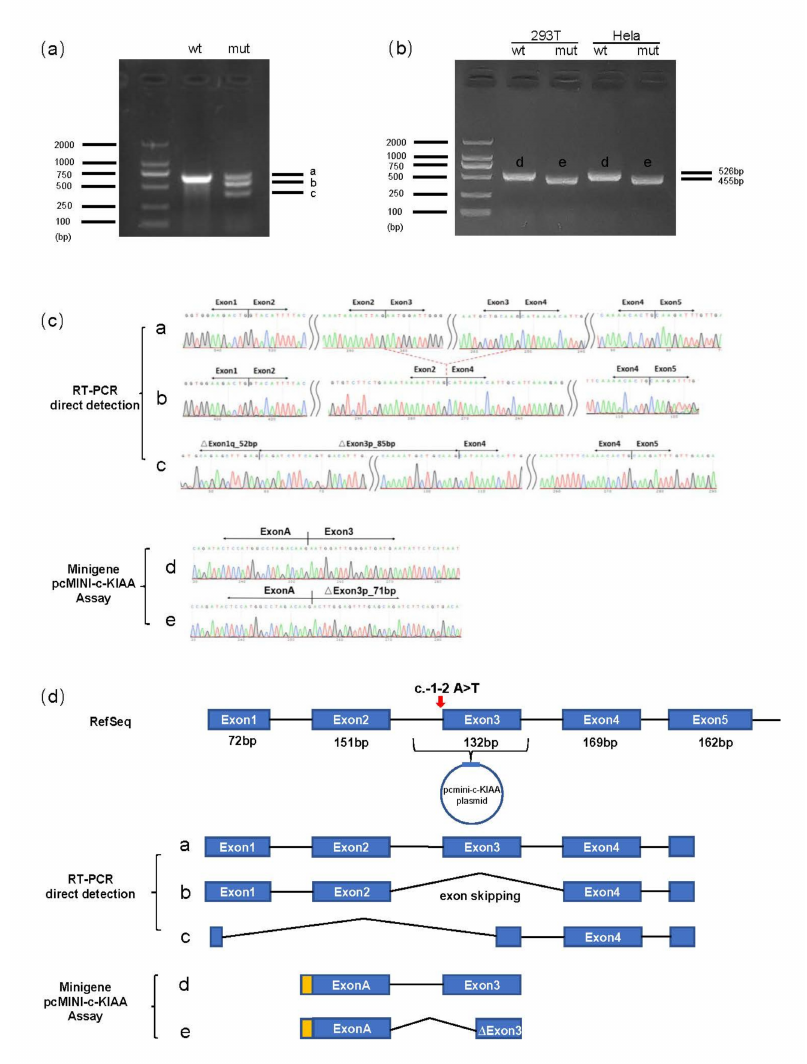
Figure 3. Blood RT-PCR and minigene assay analysis of the KIAA0825 c.-1-2A>T. ( a ) Electrophoresis results of the RT-PCR products with the father’s peripheral leukocytes; the band amplified from the control (wt) is labeled as a and the bands amplified from the father (mut) are labeled as a, b and c. ( b ) RT-PCR electrophoresis results of the minigene assay; bands from WT and the c.-1-2A>T constructs were labeled as d and e, respectively, in both HeLa and 293T cells. ( c ) The corresponding Sanger sequencing results of excised bands of a, b, c from the blood RT-PCR and excised bands of d, e from the minigene assay. ( d ) The diagram of alternative splicing events observed from the sanger sequence in the blood RT-PCR and minigene assay. The alternative splicing events from the father (mut) are labeled as a, b and c. The alternative splicing events from WT and the c.-1-2A>T constructs in minigene were labeled as d and e. Red arrow indicates the variant